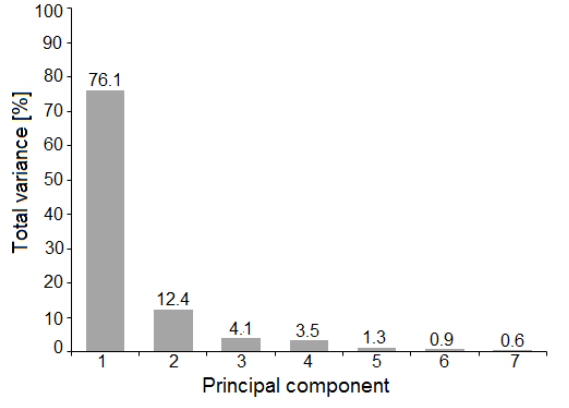
Figure 4. Total variance.